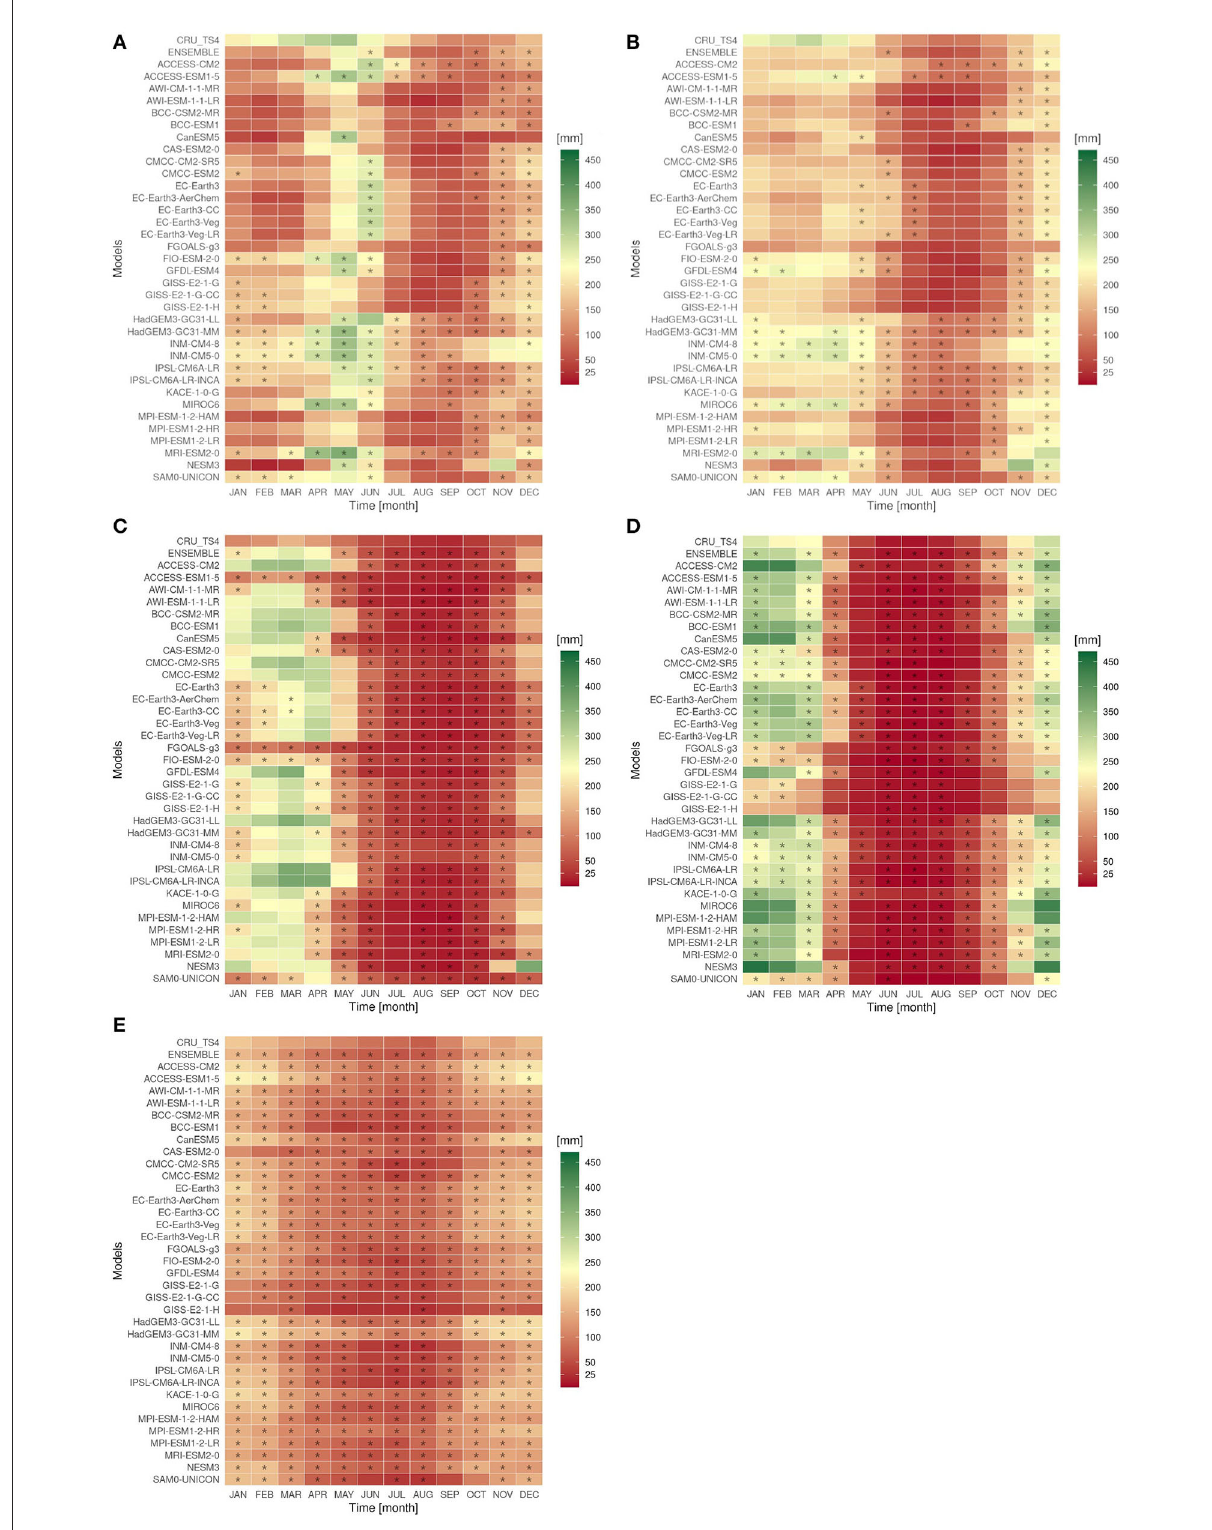
FIGURE11 Portrait diagrams of the annual precipitation cycle simulated by 36 CMIP6 models and CRU TS (observational data) over the historical period in NAZ (A) , SAZ (B) , NEB (C) , SAM (D) , LPB (E) . CMIP6 models’ results comprised within the range of two standard deviations of the observation were highlighted with an